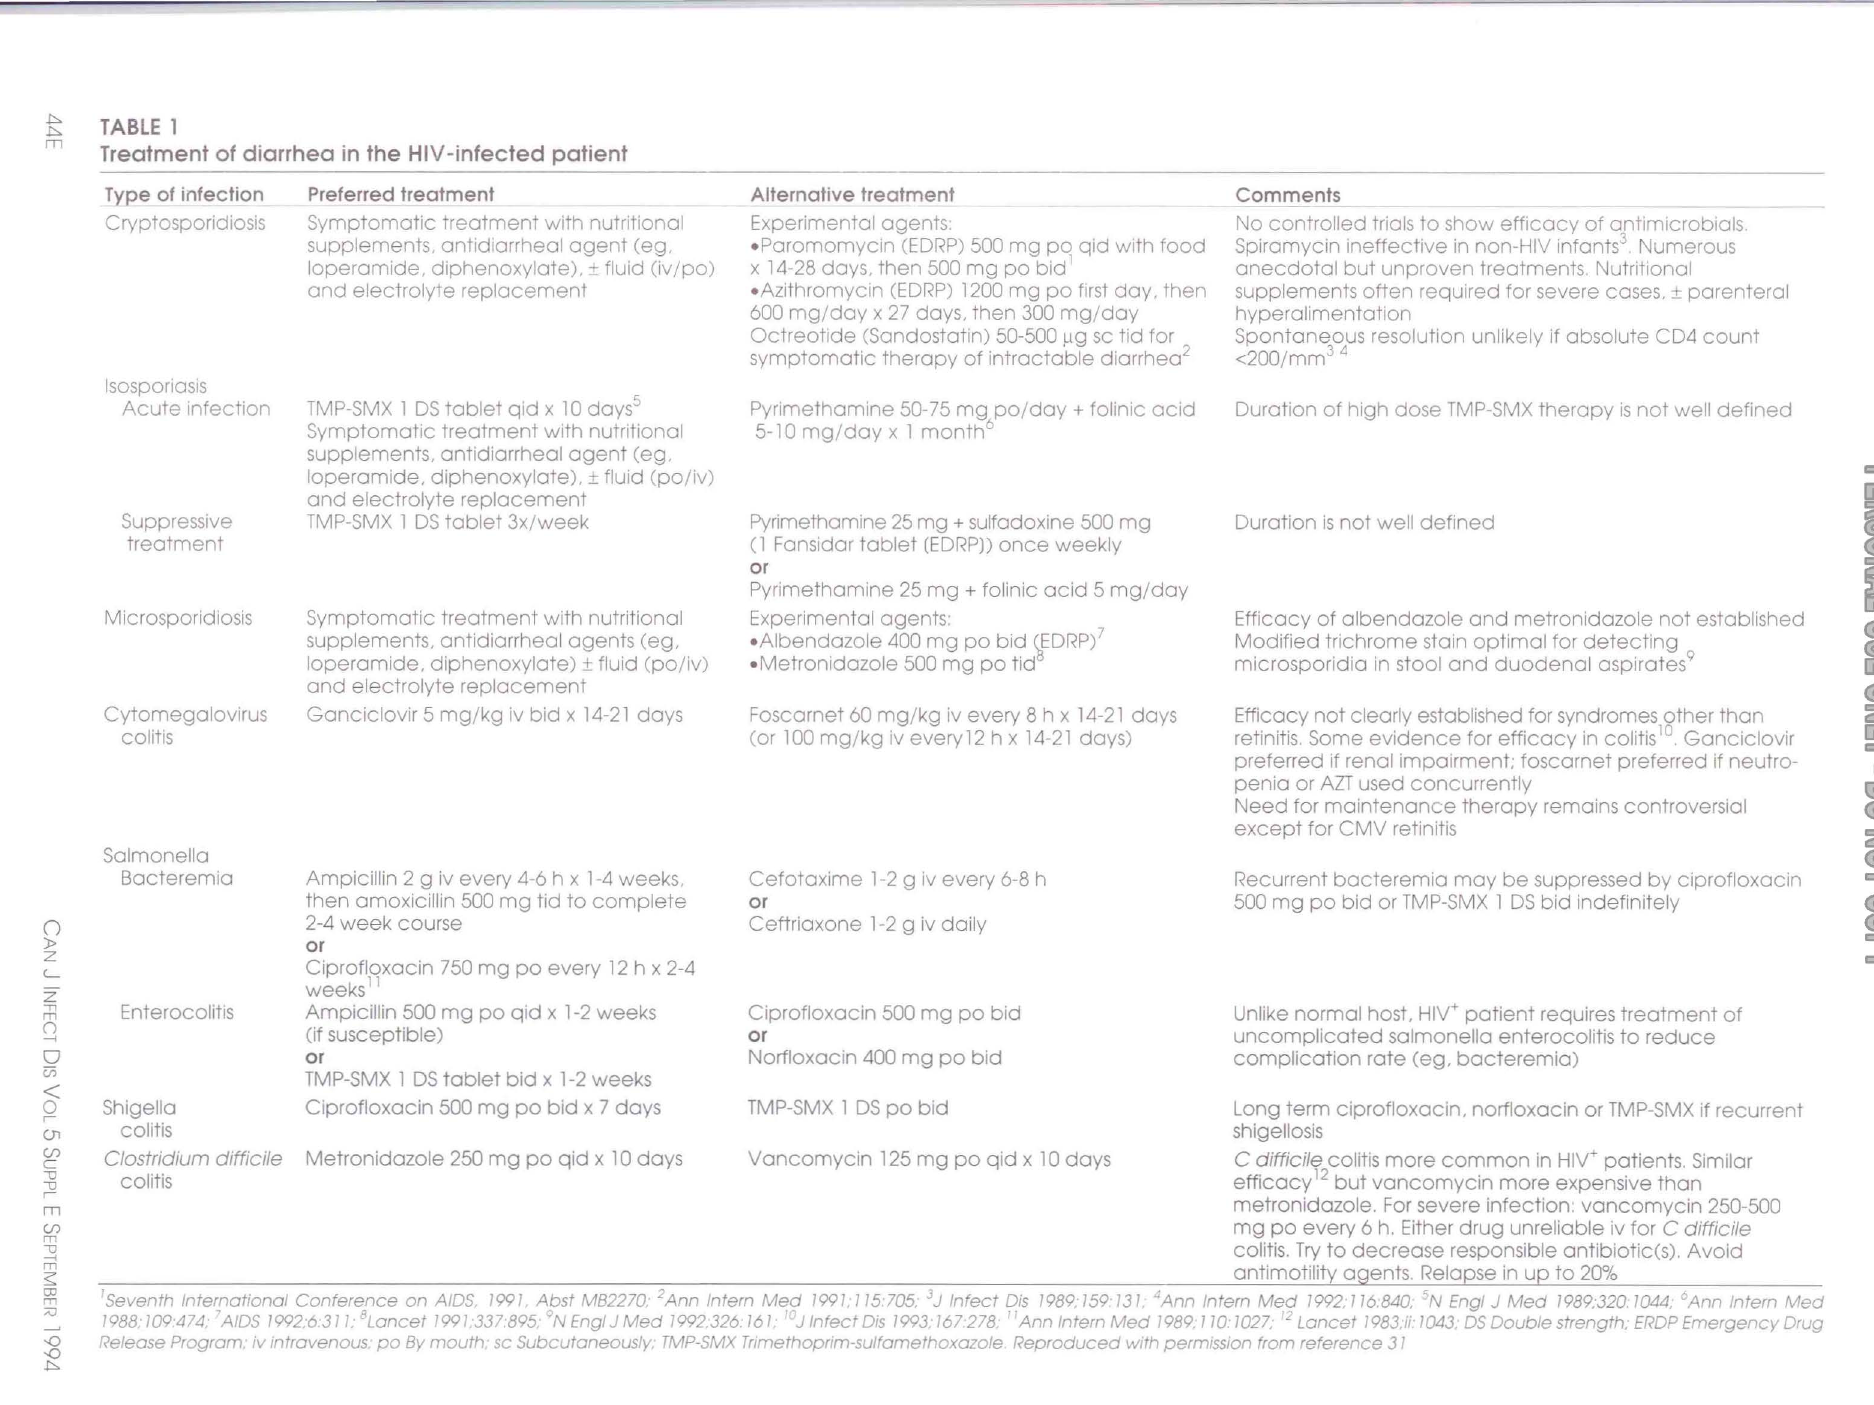
Treatment of diarrhea in the HIV-infected patient Type of infection Preferred treatment Alternative Cryptosporidiosis